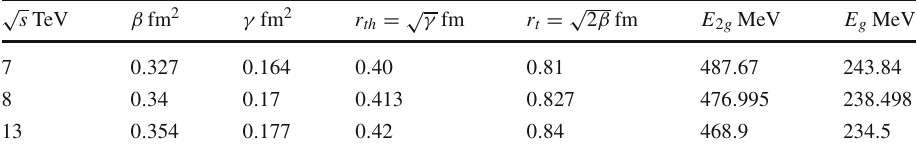
Table 4 The values of r th and r t . E 2 g and E g are the two-gluon exchange and one-gluon exchange